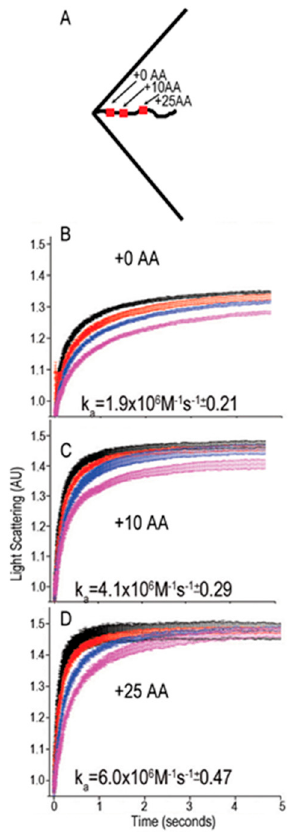
Figure 5. Accessibility could bias NEFs to bind Hsp70s towards the end of the expansion phase of the mechanochemical cycle. ( A ) Clathrin triskelia in which the Hsp70 binding site was replaced with a FLAG tag were constructed and used to assemble clathrin coats. Triskelia in which this tag was moved away from the constrained space under the triskelion vertex were also constructed by inserting 10 or 25 amino acids between the tag and upstream sequences. ( B , C ) The binding of anti-FLAG Fabs at 0.25 (magenta), 0.5 (blue), 1.0 (red), and 2.0 (black) µ M to clathrin coats assembled with FLAG-tag triskelia in which the tag has been moved downstream by 0 (panel B). Ten (panel C) or 25 (panel D) AA were measured by stop-flow light scattering. Increasing the tag’s accessibility by moving it away from the constrained space under the vertex progressively increased the association rate (k a ). Panels B–C adapted from ref. [12].